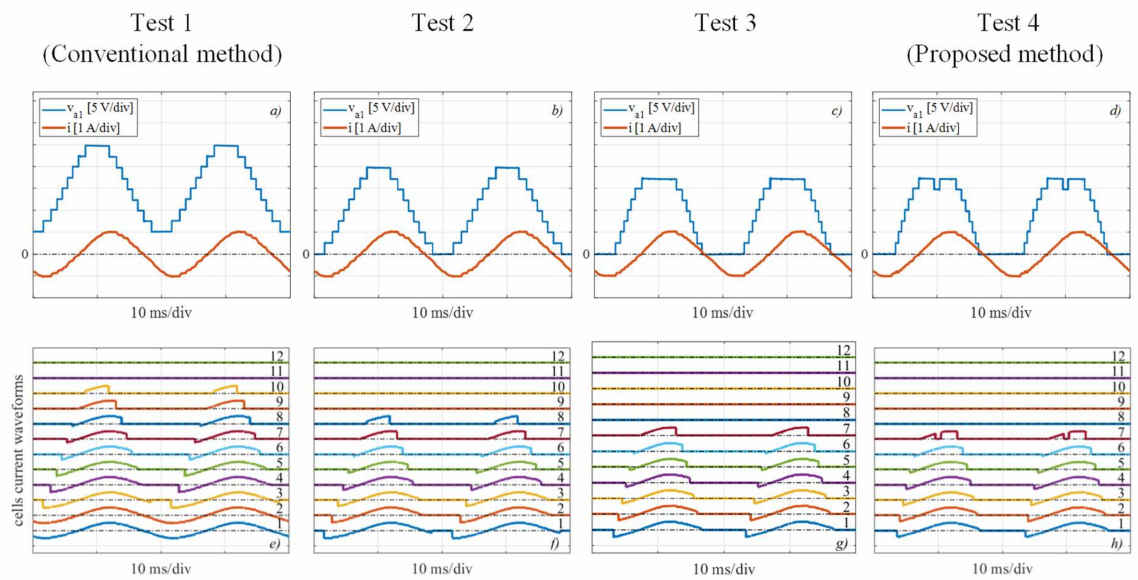
Figure 6. Experimental results: total voltage and current during: ( a ) Test 1, ( b ) Test 2, ( c ) Test 3, ( d ) Test 4; cells currents waveform during: ( e ) Test 1, ( f ) Test 2, ( g ) Test 3, ( h ) Test